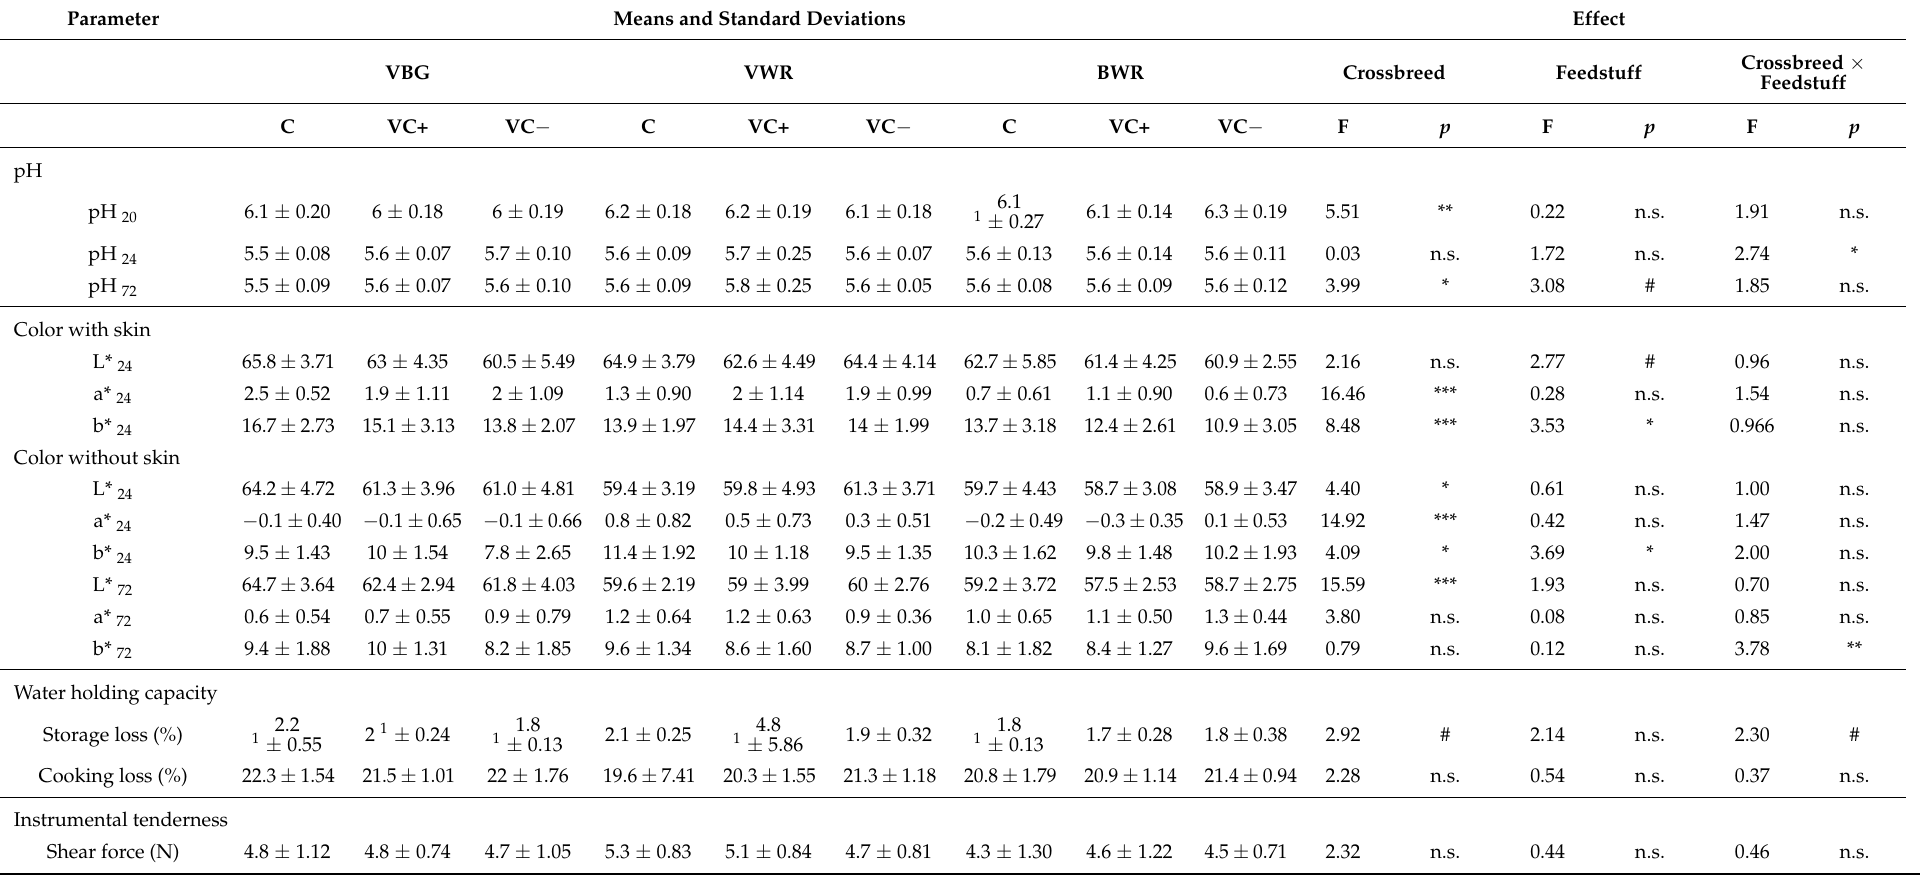
Table 3. Means, standard deviations and crossbreed, feedstuff and interaction effect for physicochemical parameters of each sample. Parameter Means and Standard Deviations Effect